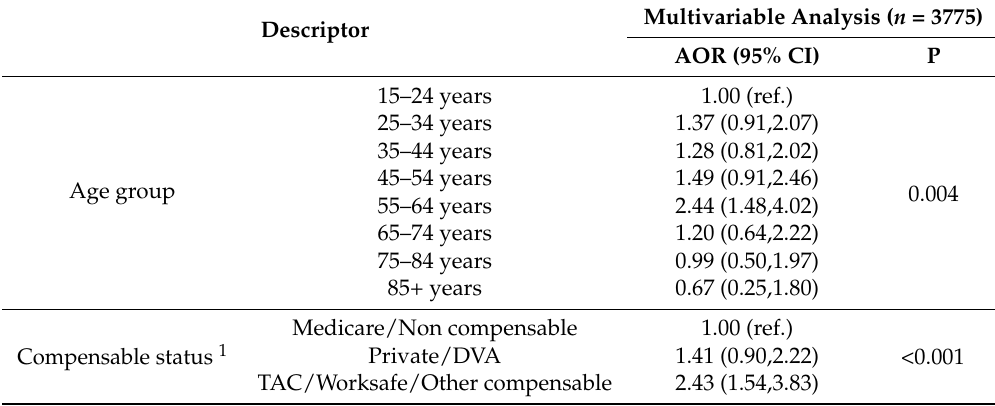
Table 4. Factors associated with the admission for fracture healing complications (multivariable